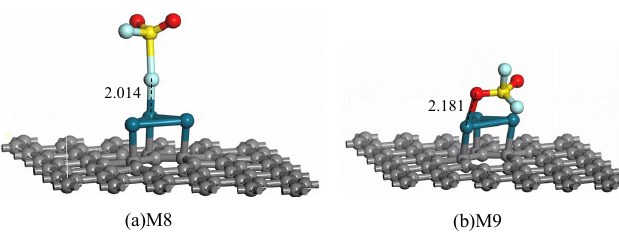
Figure 8. Adsorption structures of SO 2 F 2 on Pd 3 -graphene surface (distance in Å). Table 4. Structural parameters of SO 2 F 2 adsorption systems on Pd 3 -graphene surface. Position represents